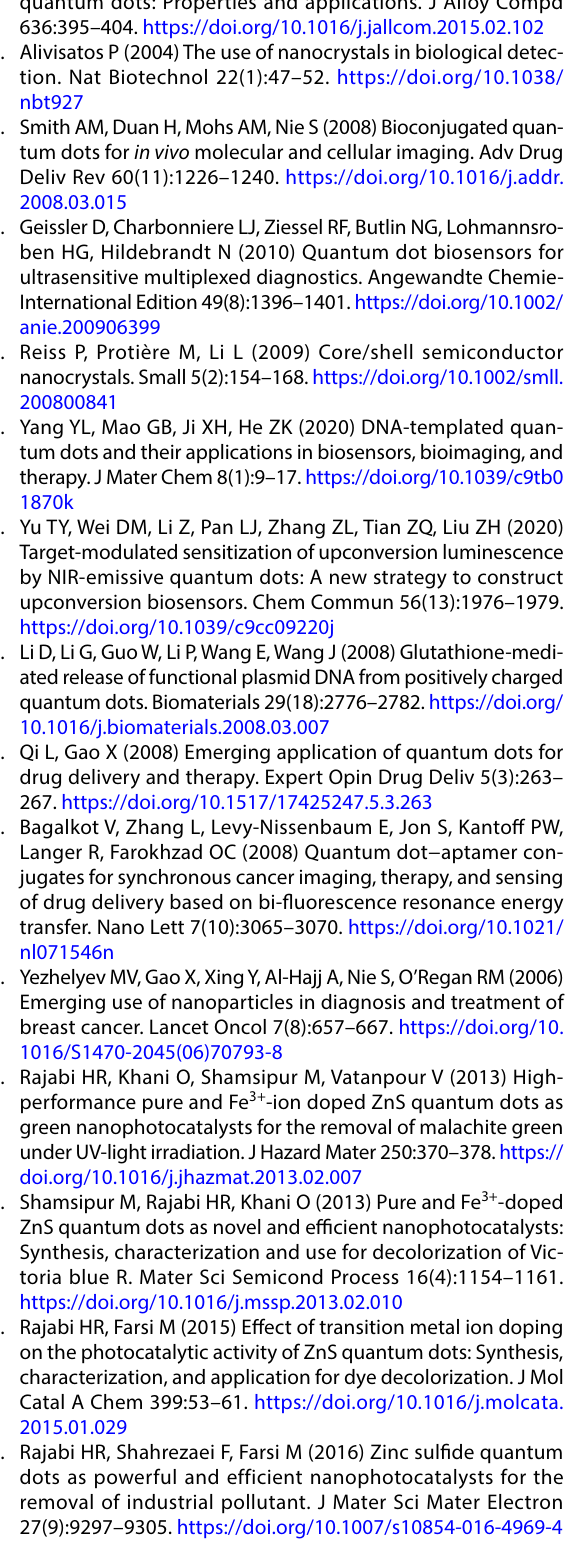
Fig. 12 Total potential energy versus inter-particle distance accord- ing to DLVO theory, showing the influence of representative diva- lent electrolyte CaCl concentrations and the absence and pres- 2 ence of the SRNOM at 10 mg/L for QDs suspended in aqueous chloride salt solutions: a 0.001 M, b 0.002 M, c 0.003 M, d 0.005 M, e 0.01 M, and f 0.05 M. Calculation of DLVO theory includes the con- tributions of the van der Waals and electric double layer (EDL) inter- actions. The net energy (Net) shown is the sum of EDL repulsion and van der Waals attraction between two approaching